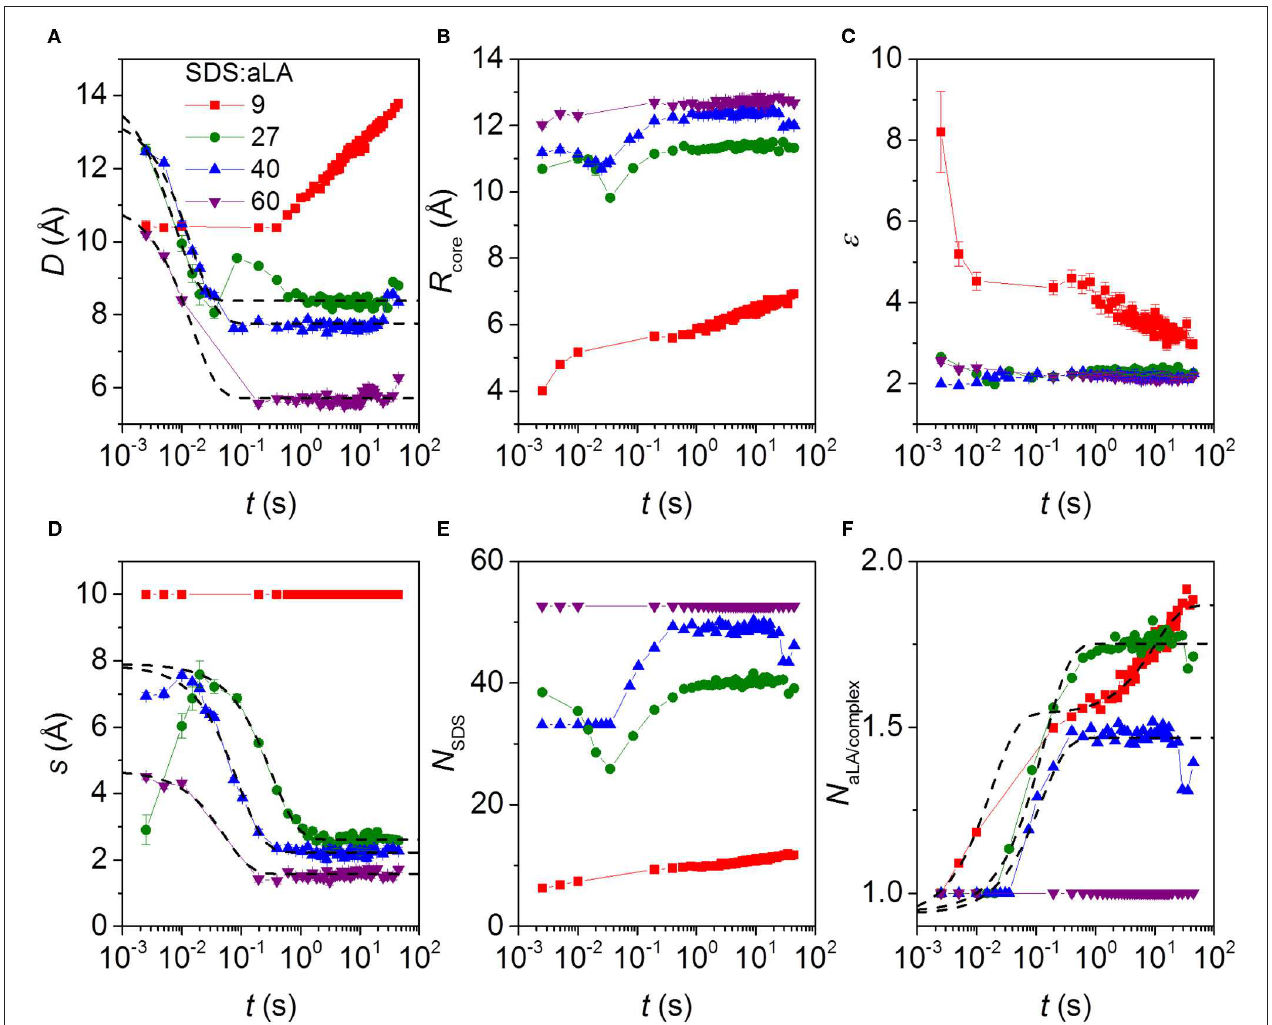
FIGURE 6 | Parameters from model fits to kinetic SAXS data after stopped-flow mixing of aLA and SDS in mixing ratios SDS:aLA 9 (red points), 27 (green points), 40 (blue points), and 60 (purple points). (A) The shell thickness, D . (B) The core radius R core . (C) Axis ratio of ellipsoidal core, ε . (D) Shift s of the core relative to the center of the outer ellipsoid in the core-shell model (see text). (E) Number of SDS molecules per micelle in protein-surfactant complex, N SDS . (F) Number of aLA molecules per complex, N α LA .